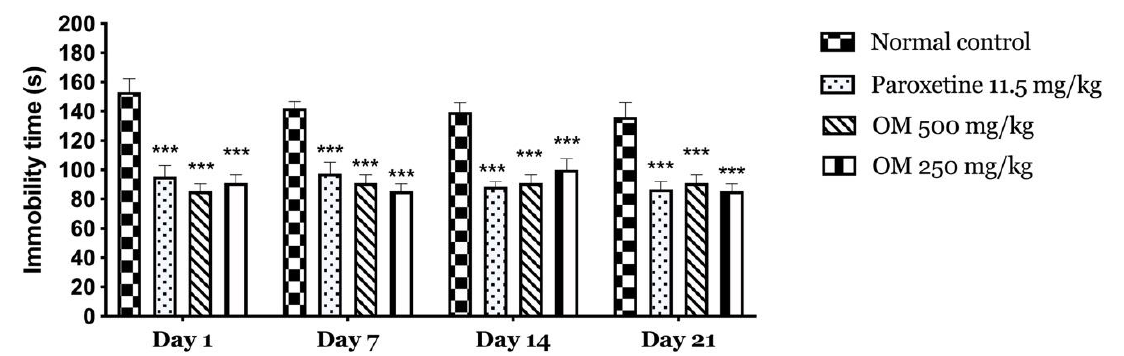
Figure 1. Effects of OM ( O. majorana ) on the Tail Suspension Test in mice on the 1st, 7th, 14th, and 21st days. Values are expressed as mean ± SEM. The analysis was done using two-way repeated-measures analysis of variance followed by Dunnett post hoc test *** p < 0.001, compared with normal control.